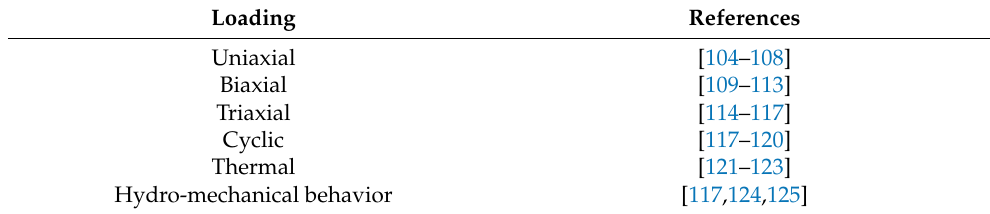
Table 2. Sources describing the type of